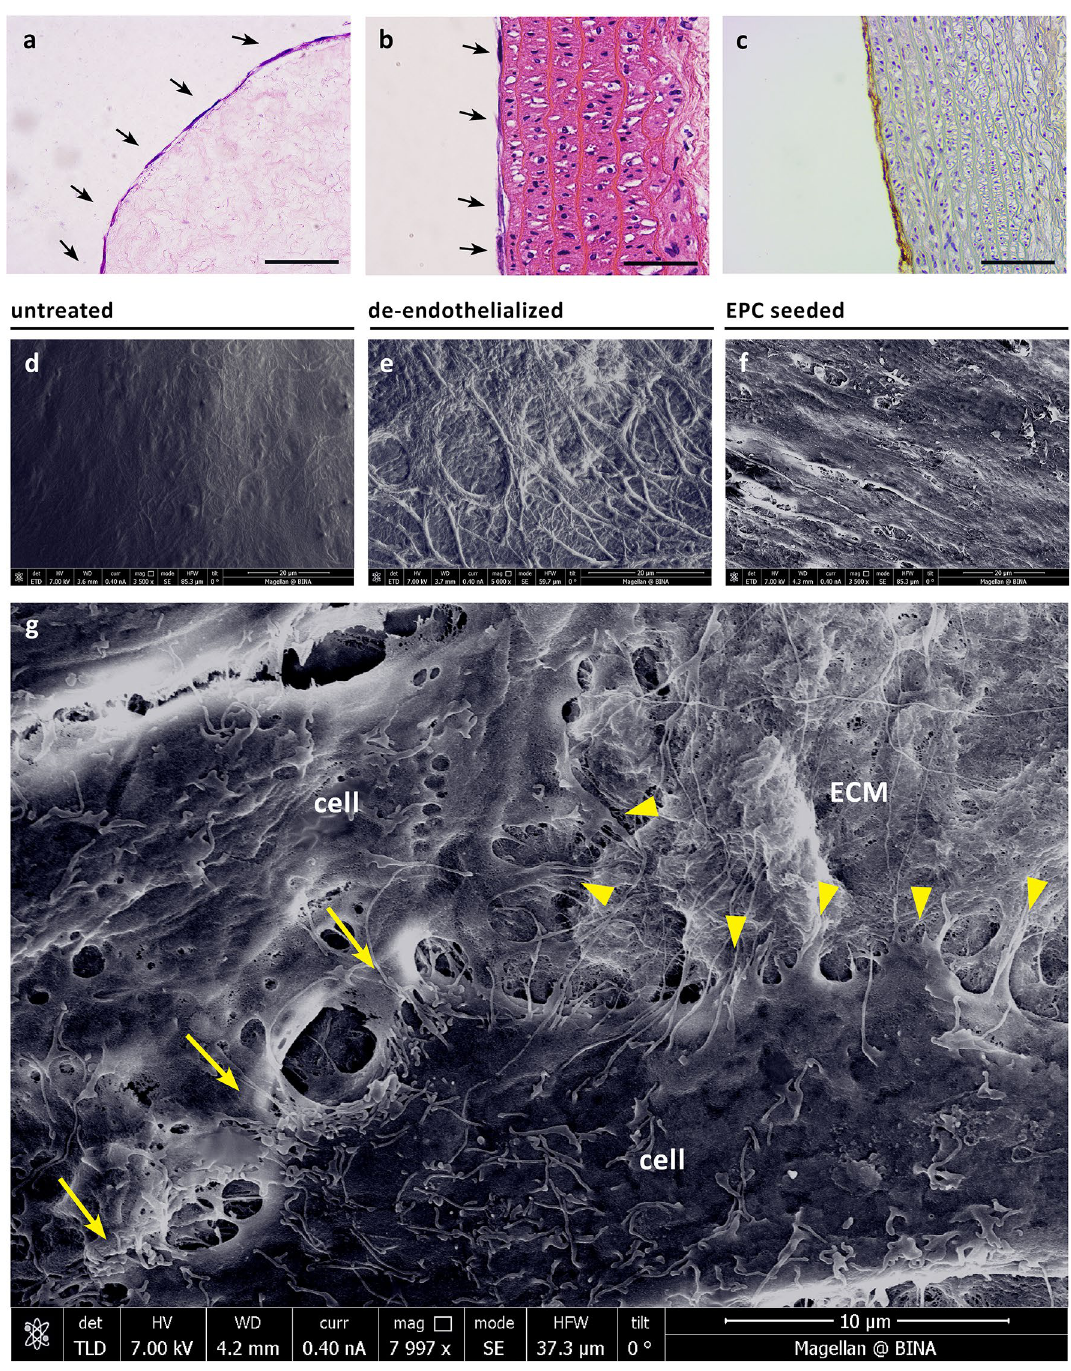
Figure 3. Cell seeding and generation of vascular chimerism in vitro. ( a ) H&E staining of human placental EPCs seeded on completely decellularized human umbilical vein. ( b , c ) H&E (B) and corresponding vWF immunohistochemistry staining ( c ) of human placental EPCs on de-endothelialized rat aorta. ( d - f ) SEM images of untreated ( d ), de-endothelialized and human EPC-seeded ( f ) rat aorta. ( g ) Corresponding high magnification SEM image of EPC-seeded aorta. Yellow arrows show cell-to-cell connections, yellow arrowheads show cell-to- ECM connections. Scale bars, 100 µm ( a , c ) and 50 µm ( b